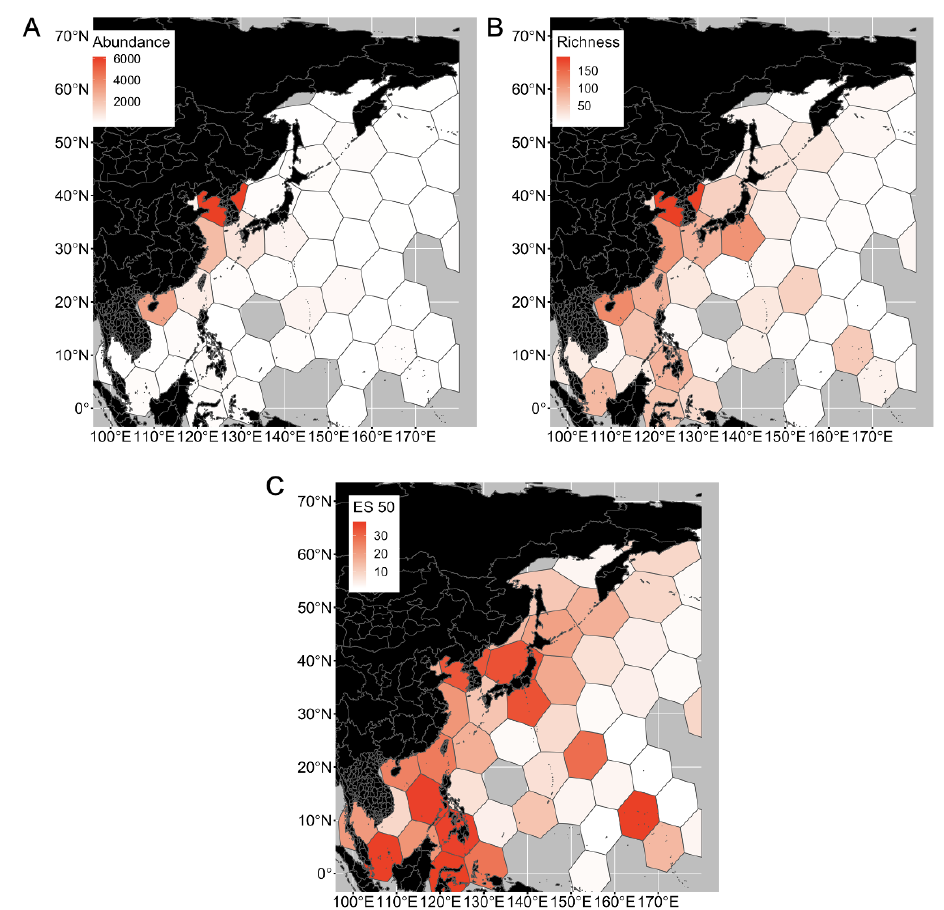
Figure 7. Distribution and diversity of Polychaeta and Sipuncula in the Northwest Pacific. ( A ) Sampling effort (number of distribution records), ( B ) alpha species richness (number of species), and ( C ) ES50 (expected number of species) of benthic polychaetes and sipunculans in the NWP per 700,000 km 2 hexagons. Empty hexagons had zero values.